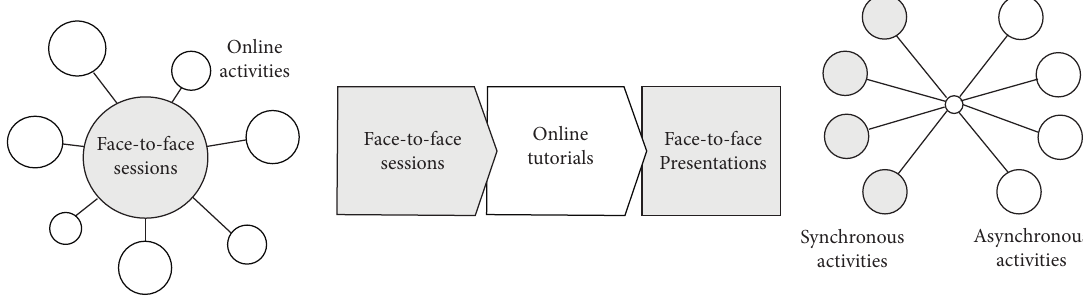
Figure 1: Models of blended learning